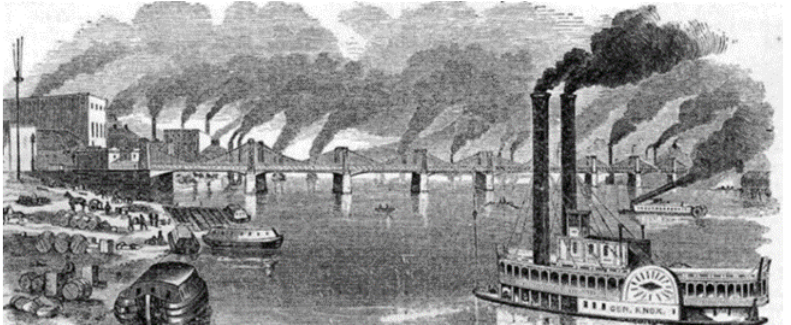
Figure 17. Monongahela Bridge, Engraving of the general view of the bridge designed by Roebling. In the foreground one of the ships of “General Knox”. Pittsburgh. 1846. Source: Engraving from issue Ballou ’ s Pictorial, 21 February 1857.